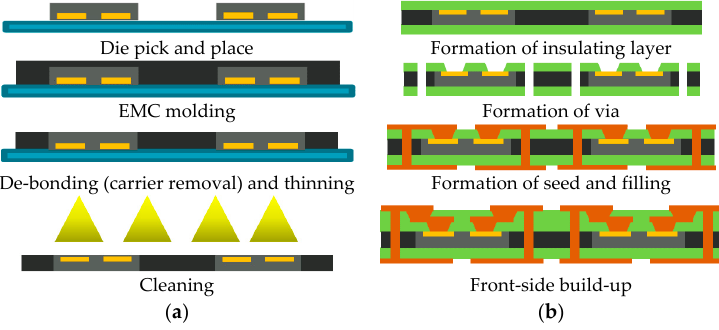
Figure 1. Wafer-level packaging process: ( a ) molding process; ( b ) redistribution layer process.